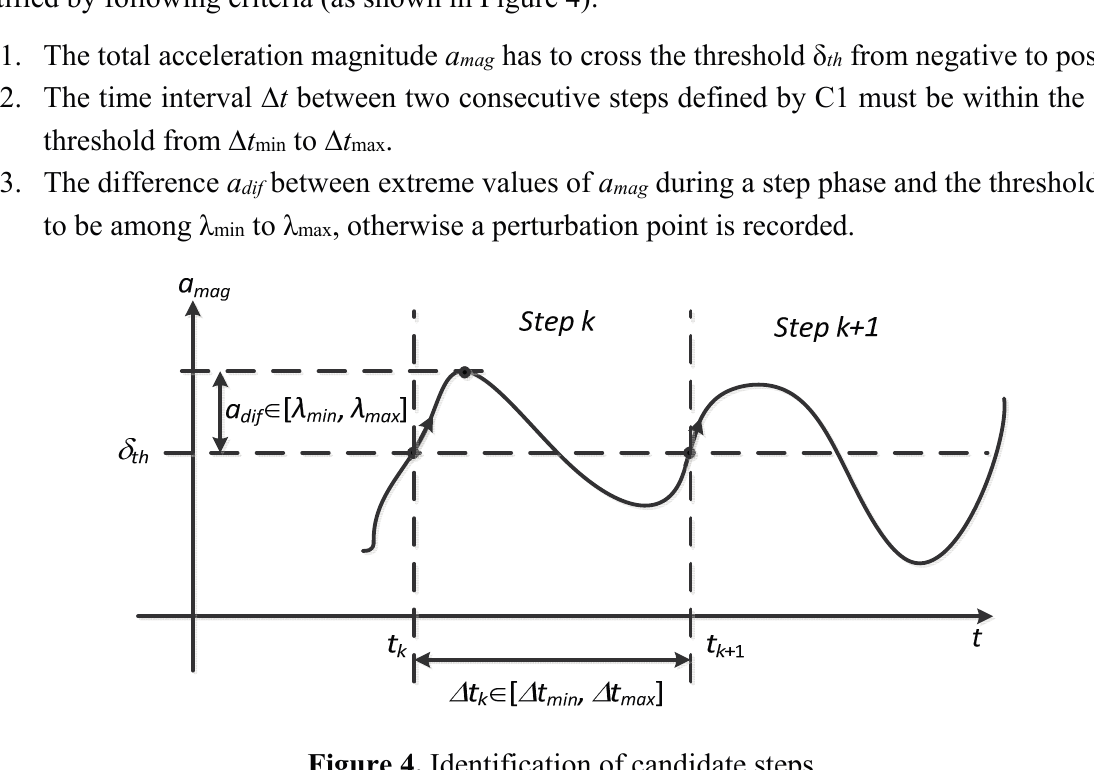
Figure 4. Identification of candidate